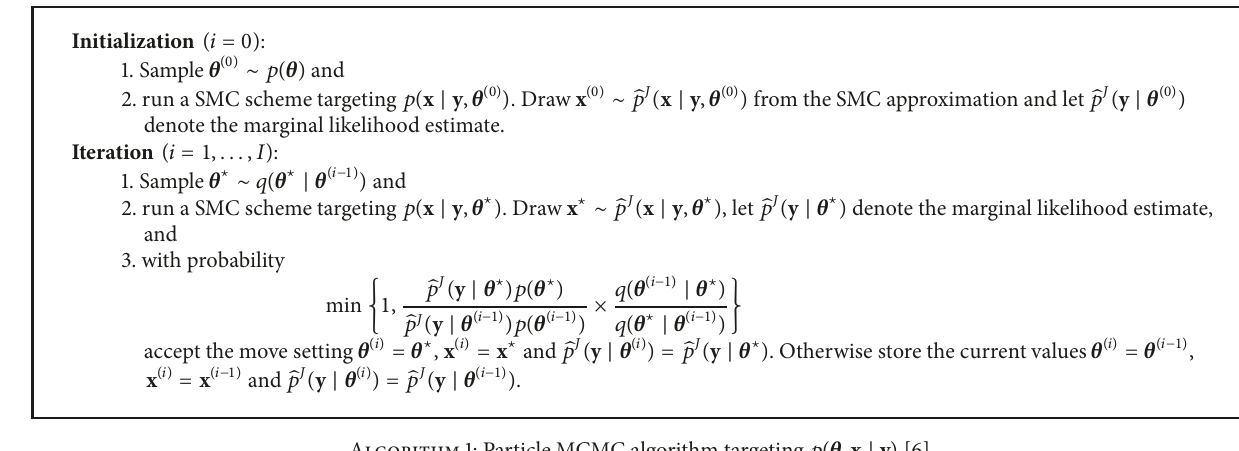
Algorithm 1: Particle MCMC algorithm targeting 𝑝( 𝜃 , x | y )